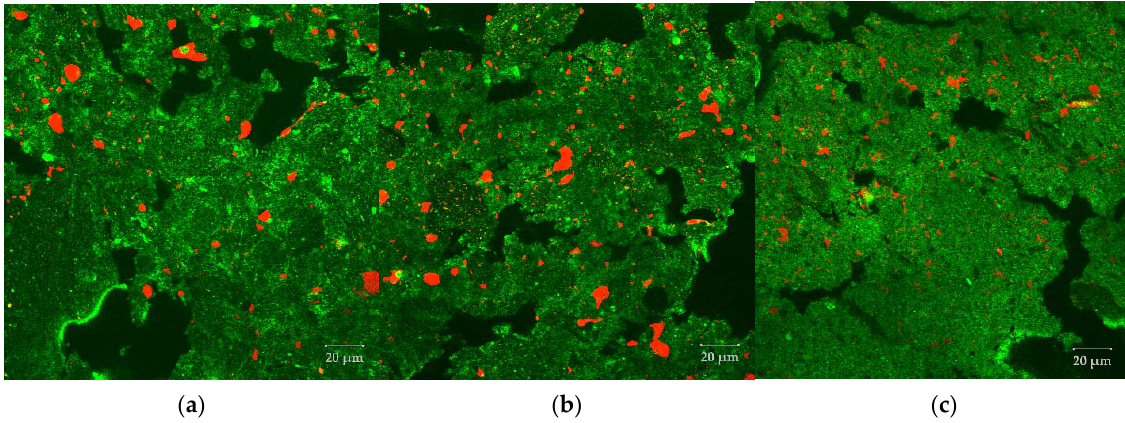
Figure 11. Effect of the screw speed on the morphology of the dispersed oil phase (red) in the protein matrix (green). CLSM images of samples extruded at different screw speeds ( a ) 200 rpm, ( b ) 400 rpm and ( c ) 800 rpm. The barrel temperature was 120 °C and oil was added at position 7.